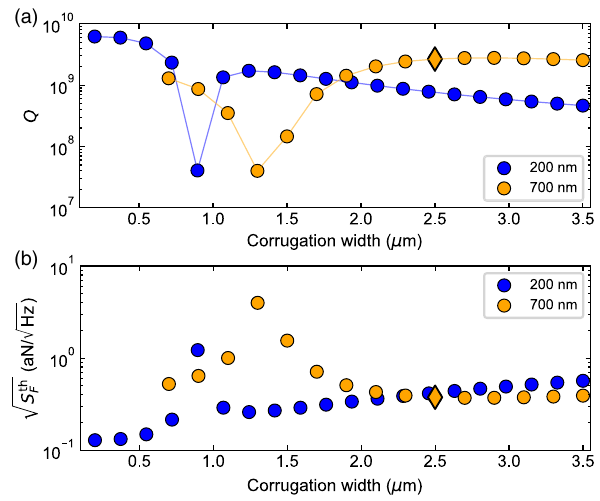
FIG. 8. Strain engineered polygon resonators. (a) Simulated Q enhancement of polygon resonators via strain engineering ( Q ) compared to the stress-preserving design ( Q stress (b) Schematic of the polygon width tapering for strain engineer- ing (i) and stress-preserved design (ii) for a square-shaped polygon.